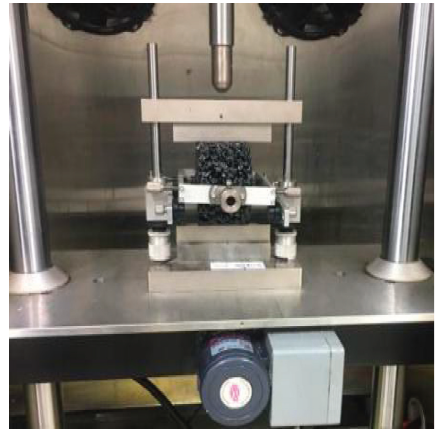
Figure 5: Indirect tensile test. Figure 6: Sample after gold